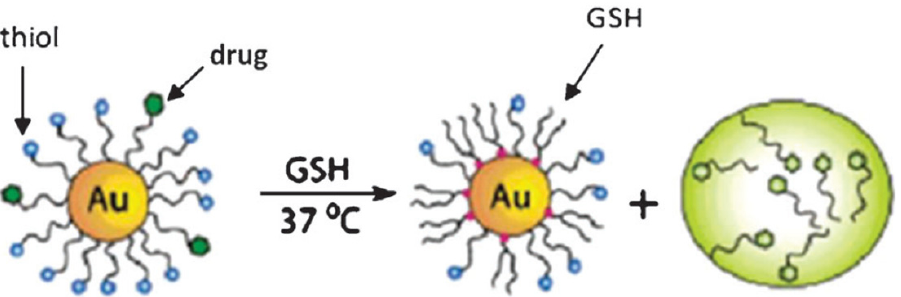
Figure 11. The exchange of intracellular ligands between glutathione and AuNP-coordinated thio- lates [205]. Copyright Elsevier 2010. lates [205]. Copyright Elsevier